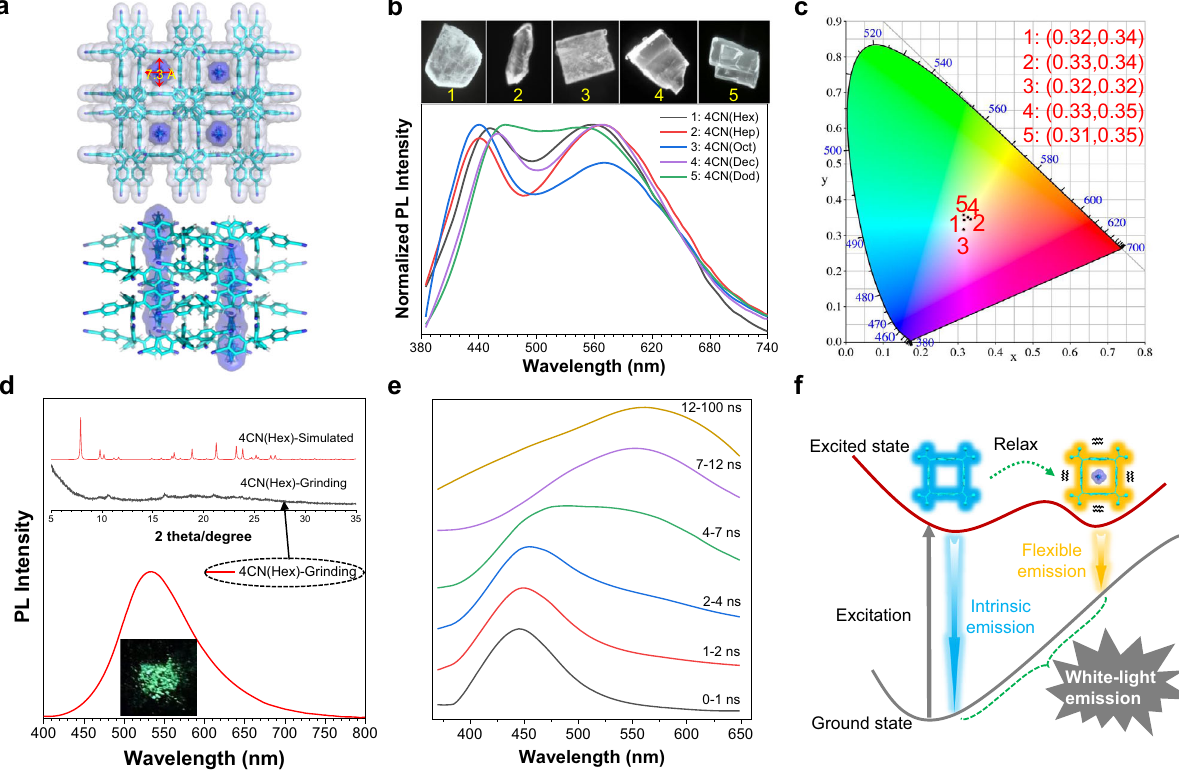
Fig. 4 Multiple white-light emissive crystals of 4CN. a Packing diagram of 4CN(Hex) along the [001] direction and [100] direction. The dimensions of the cavity are highlighted by red arrows. b Normalized fl uorescent emission spectra of 4CN(Hex), 4CN(Hep), 4CN(Oct), 4CN(Dec) and 4CN(Dod) crystals. Inset: fl uorescent images of 1 for 4CN(Hex), 2 for 4CN(Hep), 3 for 4CN(Oct), 4 for 4CN(Dec) and 5 for 4CN(Dod) crystals. c The corresponding CIE chromaticity coordinates in CIE-1931 chromaticity diagram for 1 – 5. d PL spectra of 4CN(Hex) after grinding. Inset: the PXRD patterns of simulated 4CN(Hex) and its ground sample. e Time-resolved emission spectra of 4CN(Hex) crystal. λ ex = 343 nm. f Proposed mechanism for white light emitting